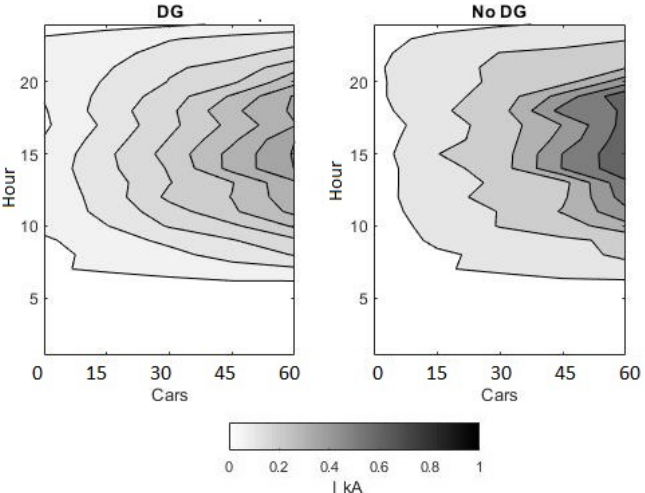
Figure 13. Maximum current requirements observed across the network over varying EV penetration with and without distributed generation (DG).